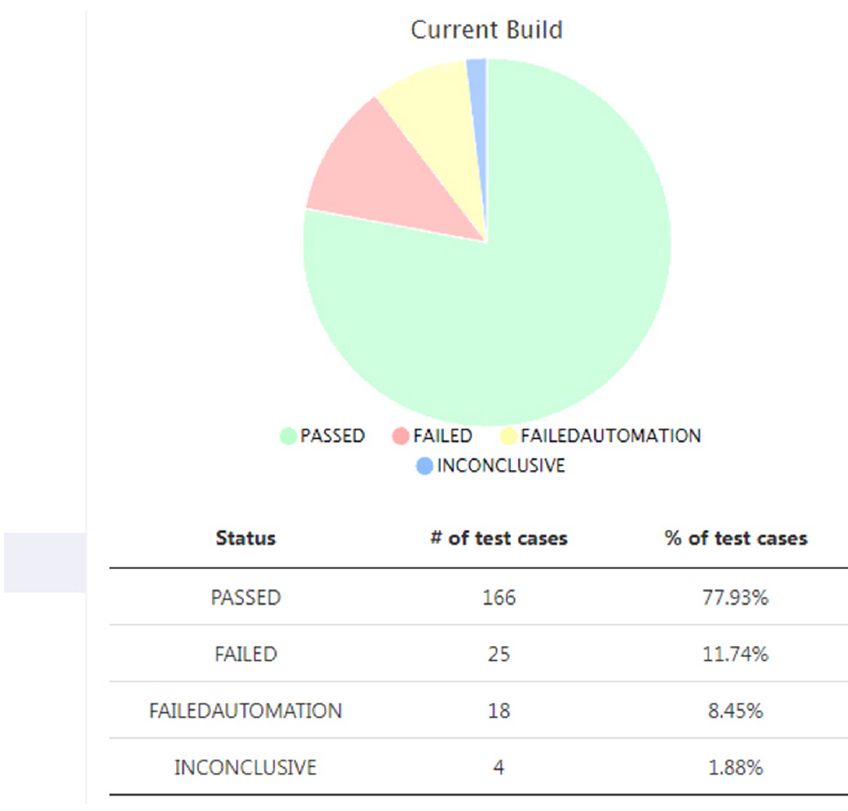
Fig. 6. Types of failures of the test